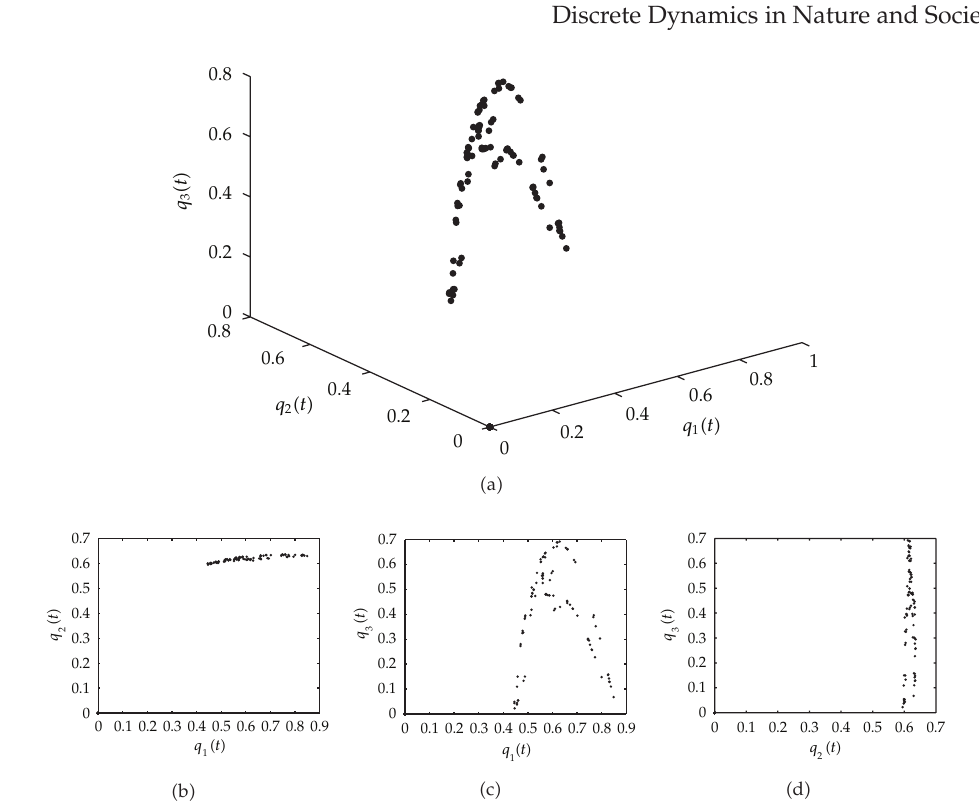
Figure 3: Three-dimensional and two-dimensional view of strange